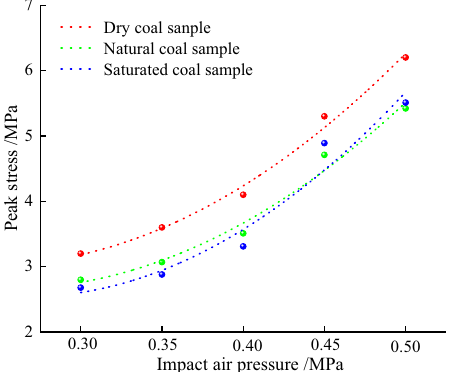
Figure 5. The trend of coal sample peak stress with loading pressure.